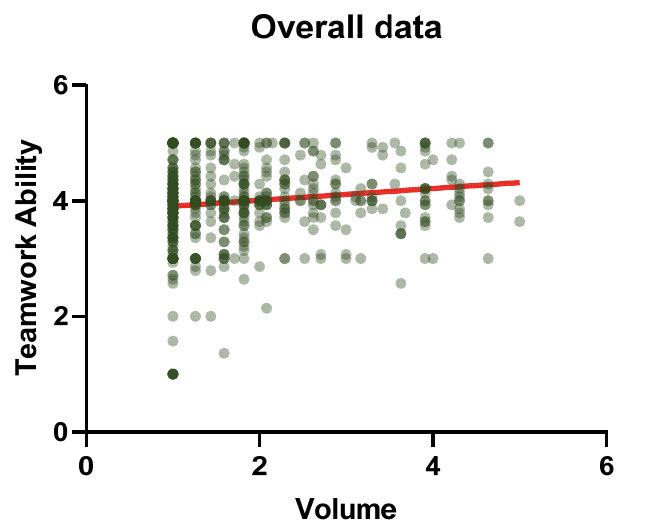
Figure 2. Regression model. Each dot represents a sample, and the darker the color, the greater the number of samples at that dot. The line reflects the trend of the dependent variable with the independent variable.